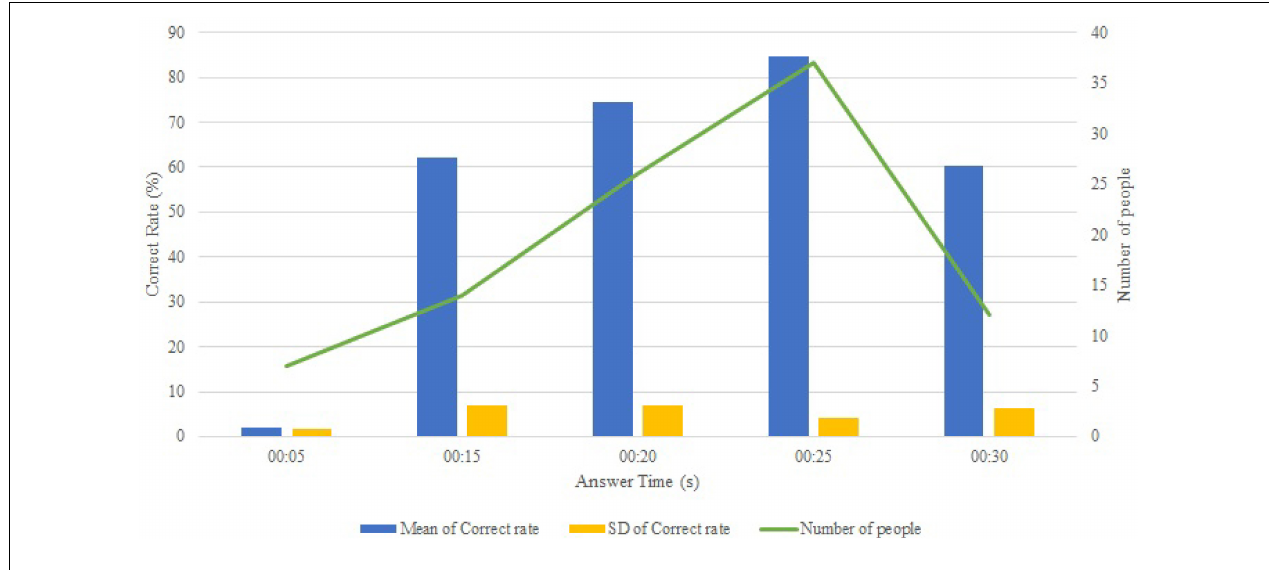
FIGURE 1 | Statistics on correct answer